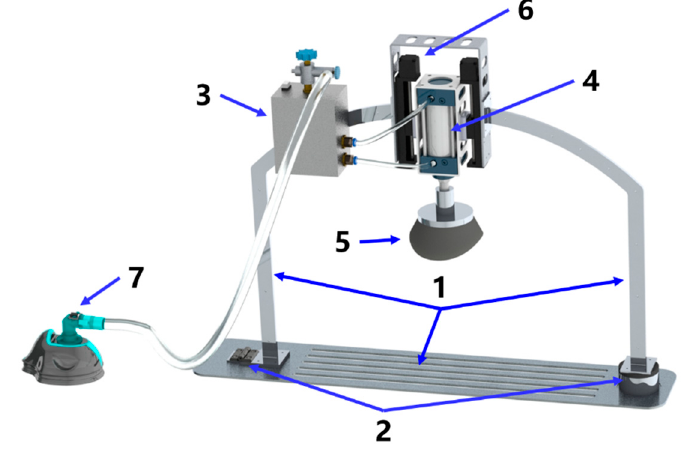
Figure 1. Novel CPR prototype.